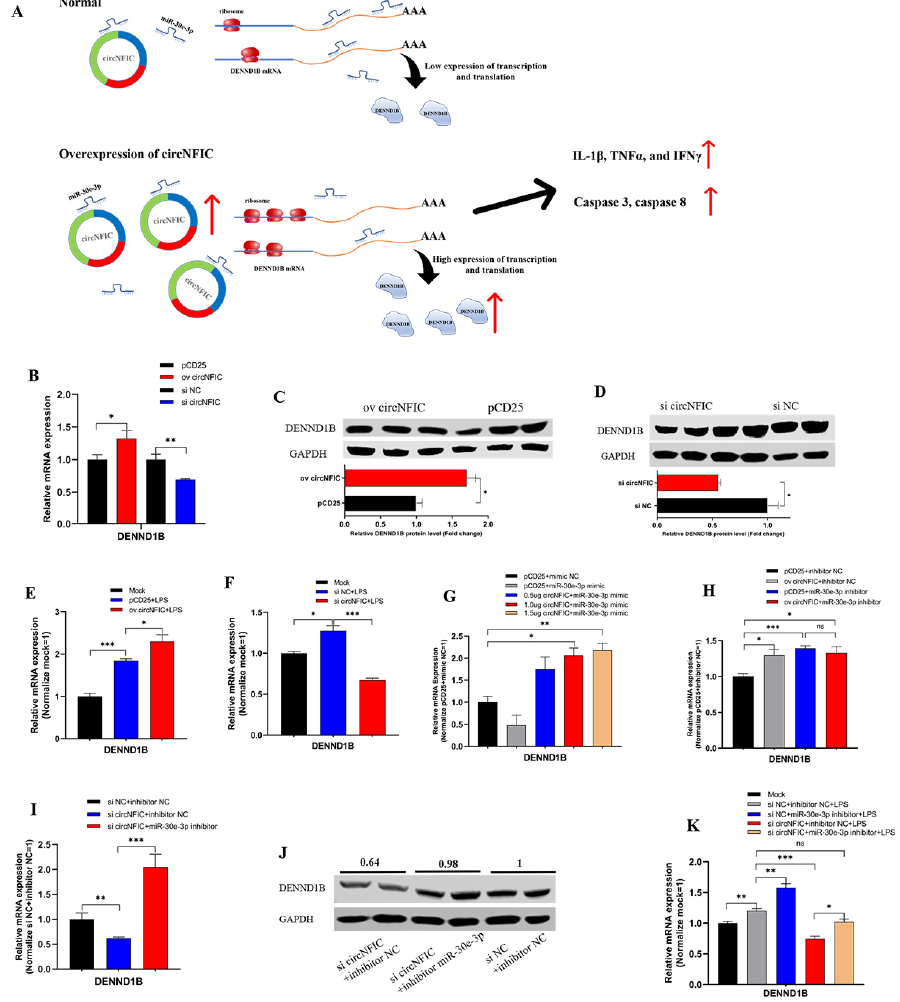
Figure 4. CircNFIC served as a sponge of miR-30e-3p to regulate the expression of DENND1B. Graphical abstract. ( A ) Graphical diagram of circNFIC promoted the expression of DENND1B and regulated inflammation and apoptosis by sponging miR-30e-3p. ( B ) The mRNA expression levels of DENND1B could be regulated by circNFIC. ( C , D ) The protein expression levels of DENND1B could be regulated by circNFIC. ( E , F ) The circNFIC also could regulate the mRNA expression levels of DENND1B. ( G ) CircNFIC could partly offset the suppression on DENND1B of miR-30e- 3p. ( H ) There is no significant difference between miR-30e-3p alone group and co-transfected with overexpression vectors and miR-30e-3p. ( I , J ) Inhibitor of miR-30e-3p could rescue the down- regulation on DENND1B of knockdown of circNFIC. ( K ) Inhibitor of miR-30e-3p could rescue the down-regulation on DENND1B of knockdown of circNFIC in HD11 exposed to LPS. Data are presented as mean ± SEM (n ≥ 3 biologically independent samples). * p < 0.05; ** p < 0.01; *** p < 0.001; ns: no significance (Student’s t